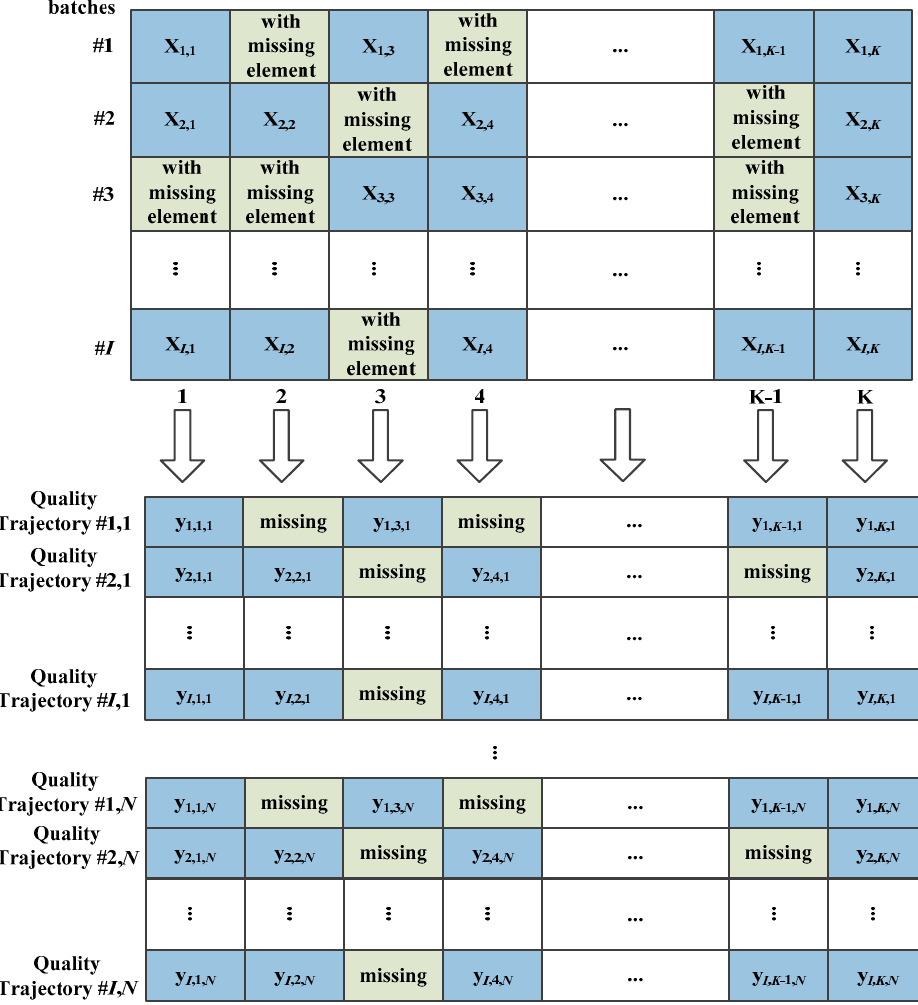
Figure 1. Bagging for batch processes with I batches and N output modes.